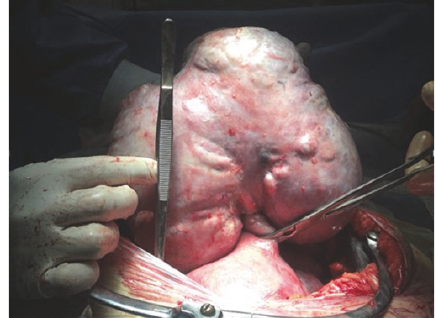
Figure 1: Myoma of the uterine fundus with evidence of torsion of its